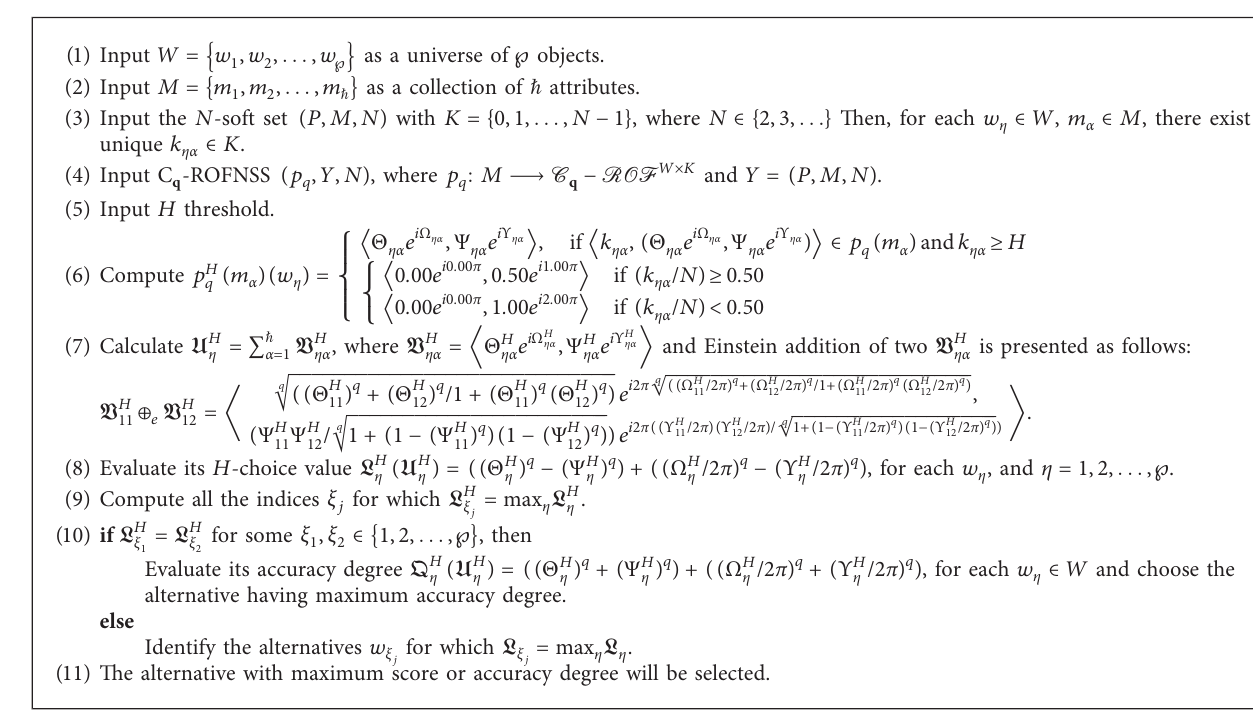
A LGORITHM 2: The algorithm of H -choice values of C